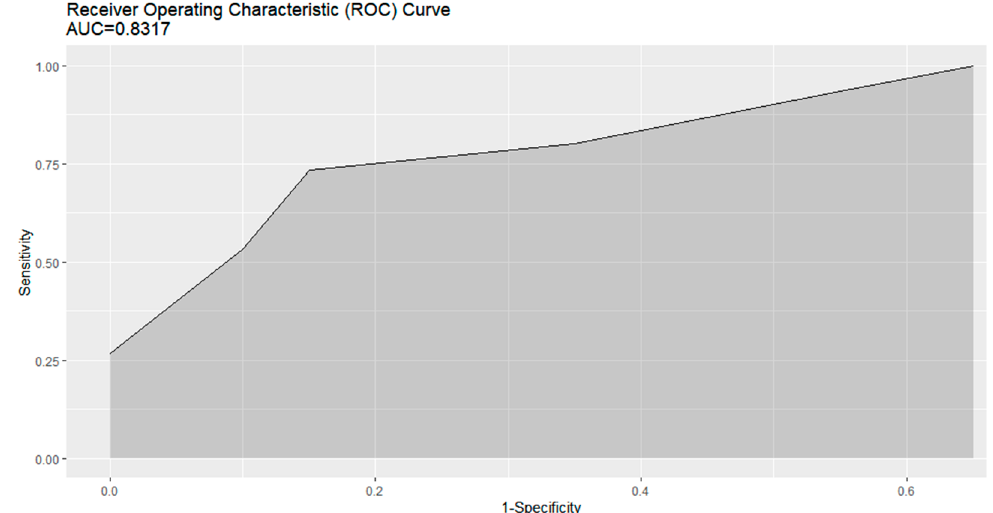
Figure 3. Receiver-operator curve with confidence intervals of the SMGOP for predicting muscle predominant type of Graves’ orbitopathy in patients with moderate to severe type of Graves’ orbitopathy. SMGOP; The Score for Muscle predominant type of Graves’ orbitopathy Risk Prediction.